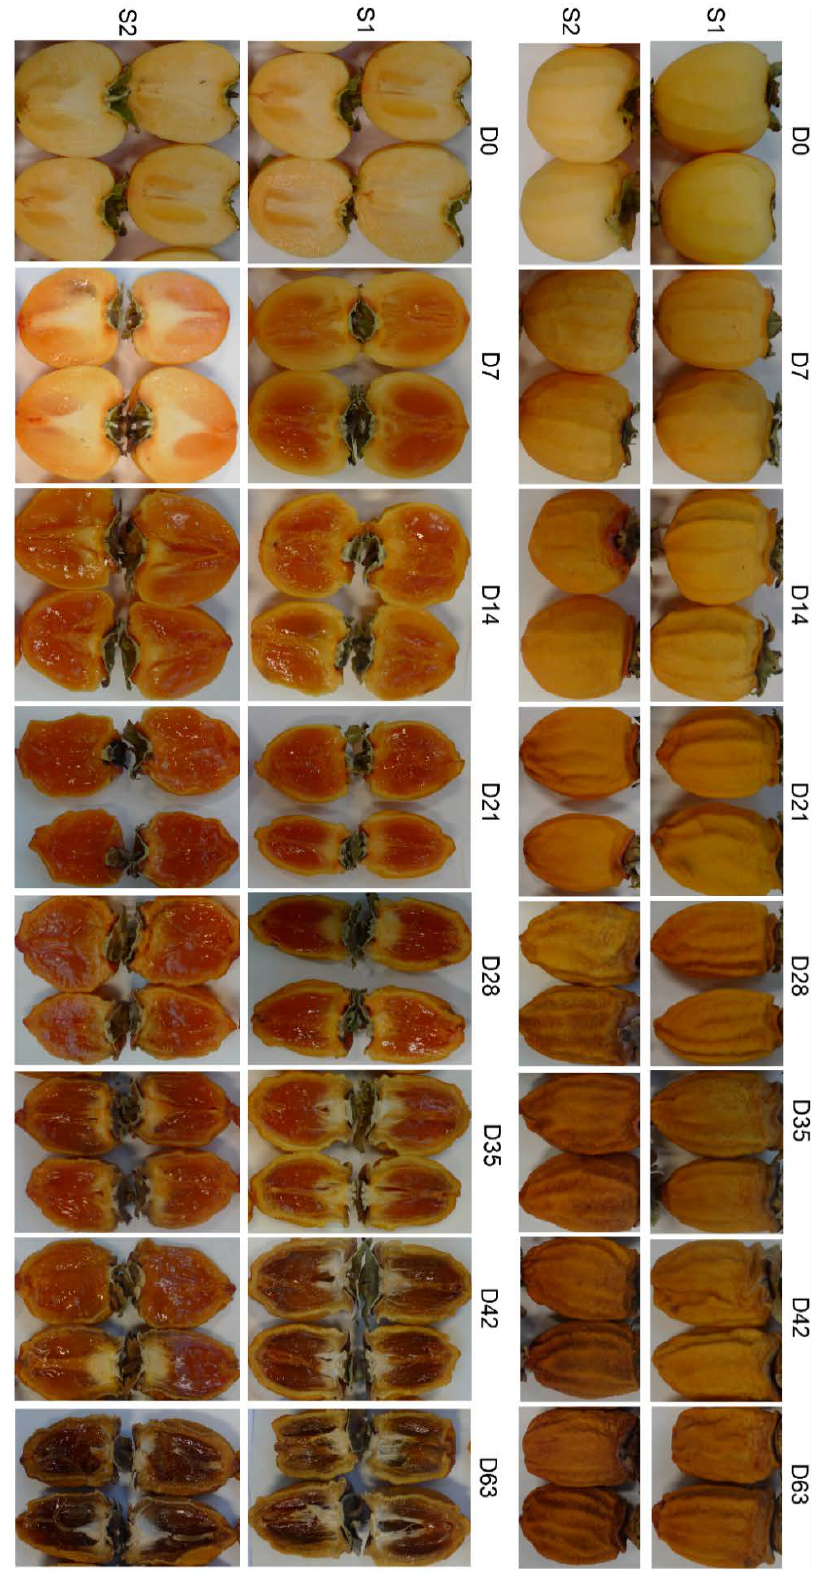
Figure 2. Captured images of persimmon cv. Rojo Brillante in two maturity stages (S1 and S2) during the drying process.